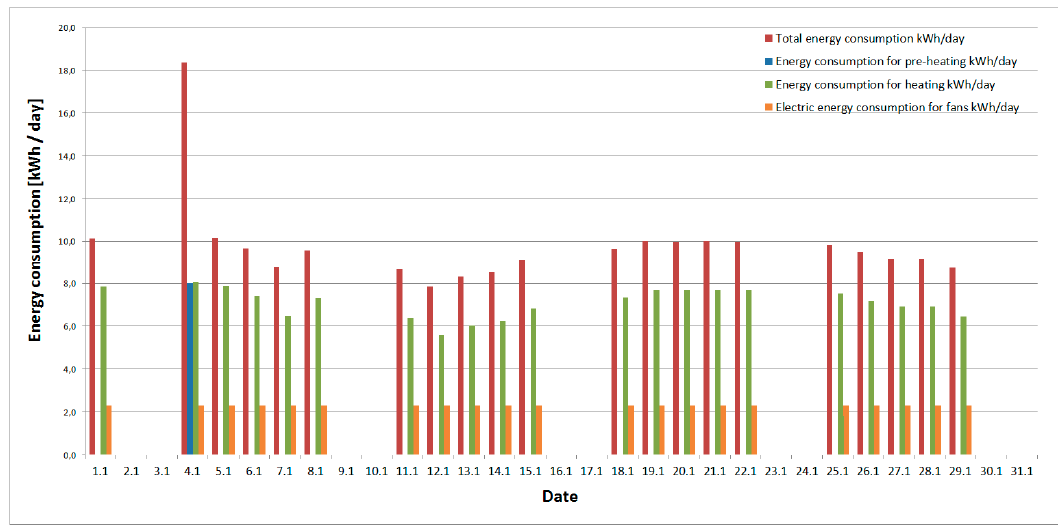
Table 3. Measured Indoor Environmental